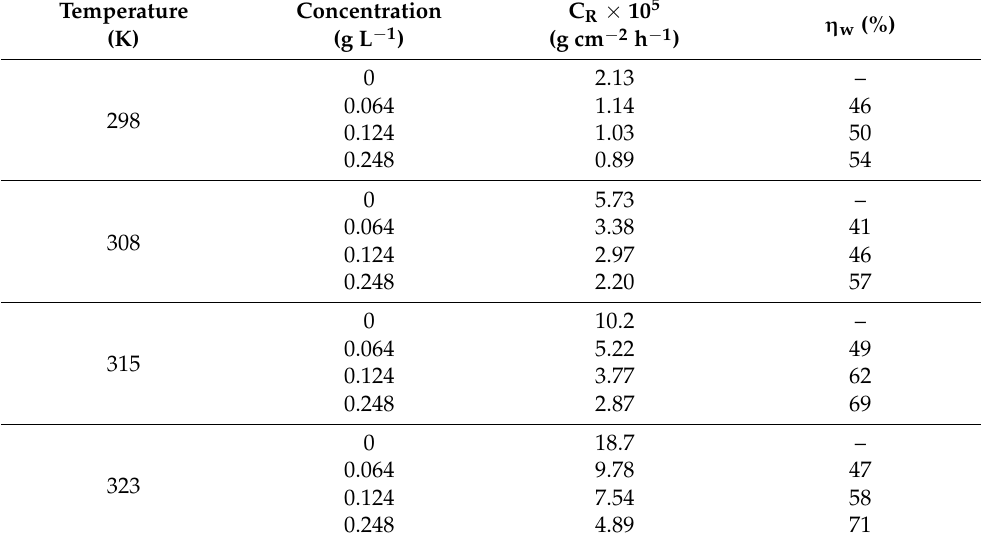
Table 1. Weight loss of aluminum in a 0.1 M HCl solution, at different temperatures and concentra- tions of Ilex paraguariensis as an inhibitor, after 48 h immersion time.